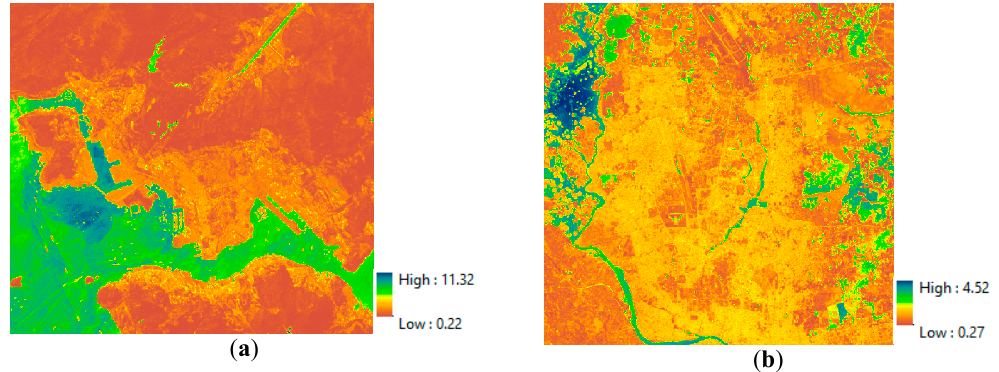
Figure 12. TCWVI-based maps of the two study sites: ( a ) Hong Kong and ( b ) Dhaka.